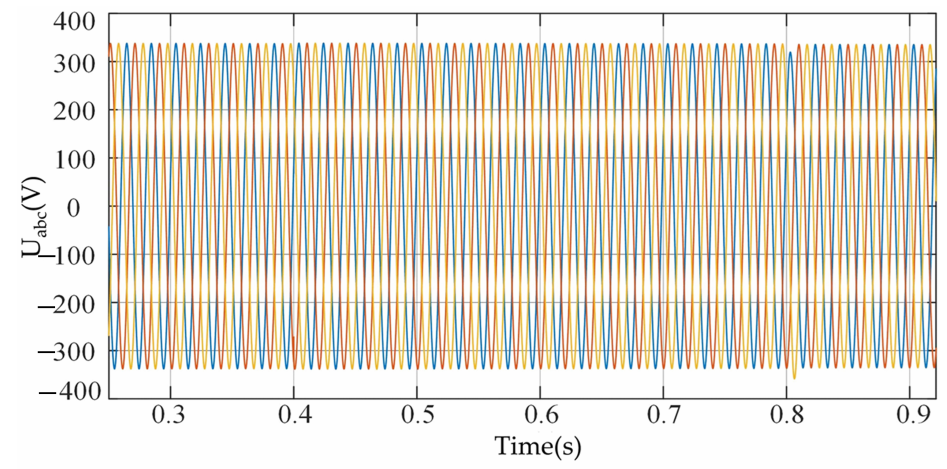
Figure 7. Variation of three-phase voltage in case-1.